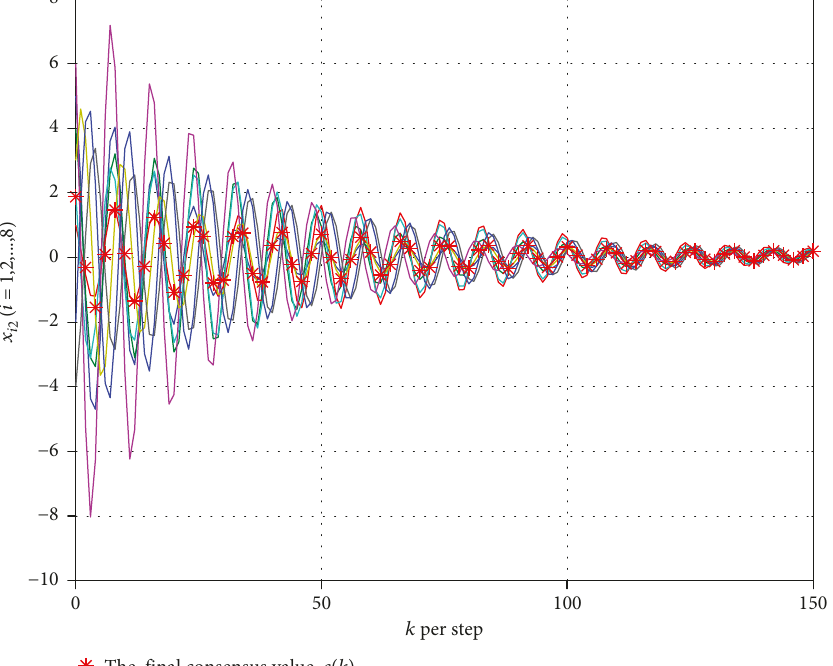
Figure 3: State 2 trajectories of swarm system